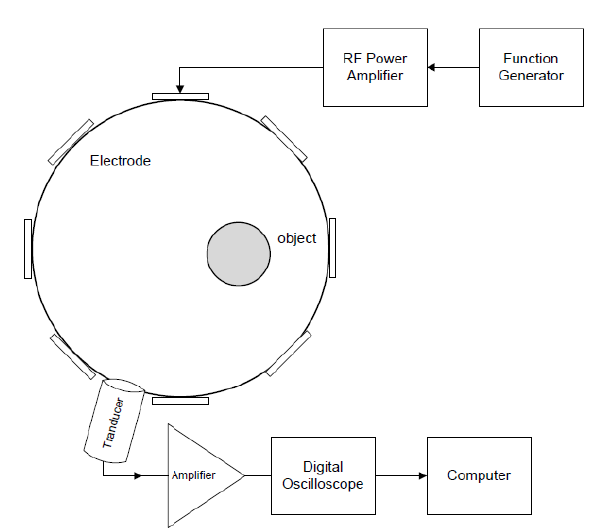
Figure 5: Experiments configuration of ultrasound reflection tomography